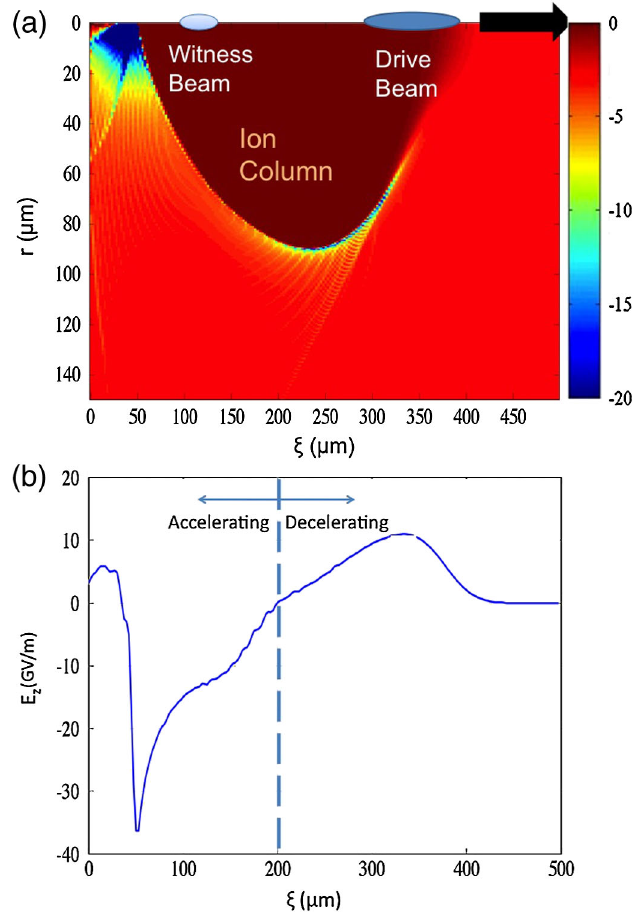
FIG. 1. (a) Density of the plasma electrons obtained from a numerical simulation using the code QUICKPIC [3], showing the pure and (initially) uniform ion column created by the drive bunch moving from left to right. The drive and witness bunch are shown schematically (their transverse sizes are exaggerated for the sake of better visibility). (b) Resulting on-axis longitudinal electric field E z showing that the drive bunch is in the decelerat- ing phase of the wakefield ( (cid:7) (cid:6) 320 (cid:5) m ) while the witness bunch is placed in the accelerating phase ( (cid:7) (cid:6) 110 (cid:5) m ). Evidence of accelerating field amplitude flattening in the witness bunch region around (cid:1) 15 GV = m is due to the loading of the wakefield. In the pure ion column with no ion motion, the focusing force is linear and the witness bunch incoming emit- tance is preserved. The parameters are those of Table I. Bunches are 2 : 5 (cid:2) z long but for the sake of better visibility, bunches transverse sizes are exaggerated. The color bar on (a) indicates =n n e e 0 the ratio of the local plasma electron density to the unperturbed plasma density (value of (cid:1) 1 ). bunch quality, are around 2 (cid:3) 10 10 and 0 : 5 (cid:3) 10 10 electrons, respectively. The collider luminosity ( (cid:2) 2 (cid:3) 10 34 s (cid:1) 1 cm (cid:1) 2 ) calls for extremely small normal- ized emittances ( (cid:6)" x ¼ 10 and (cid:6)" y ¼ 0 : 04 mm mrad at 250 GeV [5,7]). In order to minimize synchrotron radiation loss and the production of large amounts of gamma radia- tion, the bunches transverse size is also small. In particular,